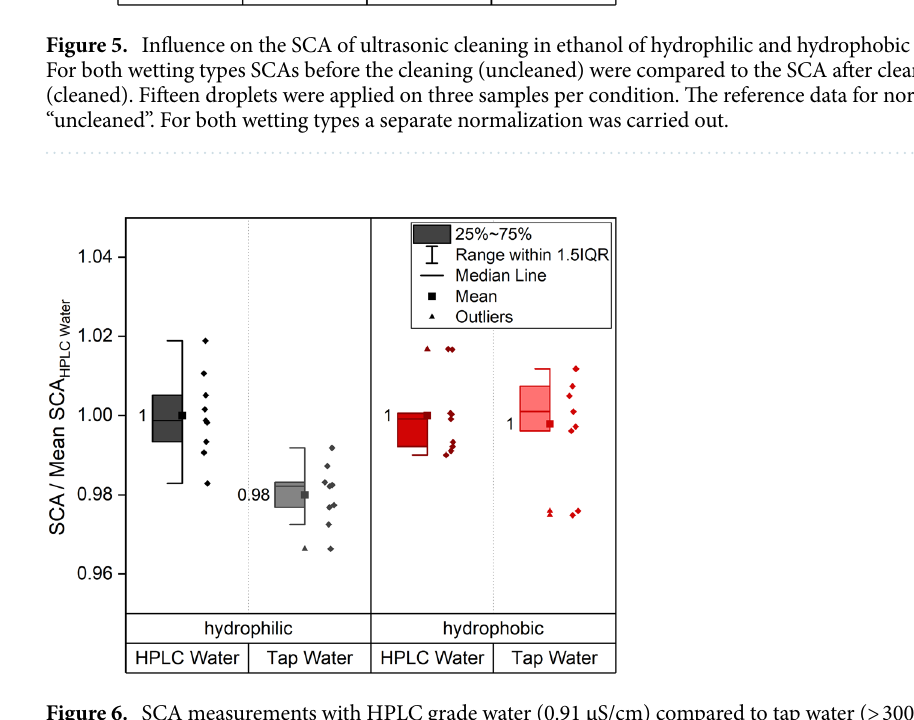
Figure 6. SCA measurements with HPLC grade water (0.91 µS/cm) compared to tap water (> 300 µS/cm). Measurements were performed on three different samples with three droplets per sample per water grade and sample condition. The reference data for normalization is “HPLC Water”. For both wetting types a separate normalization was carried